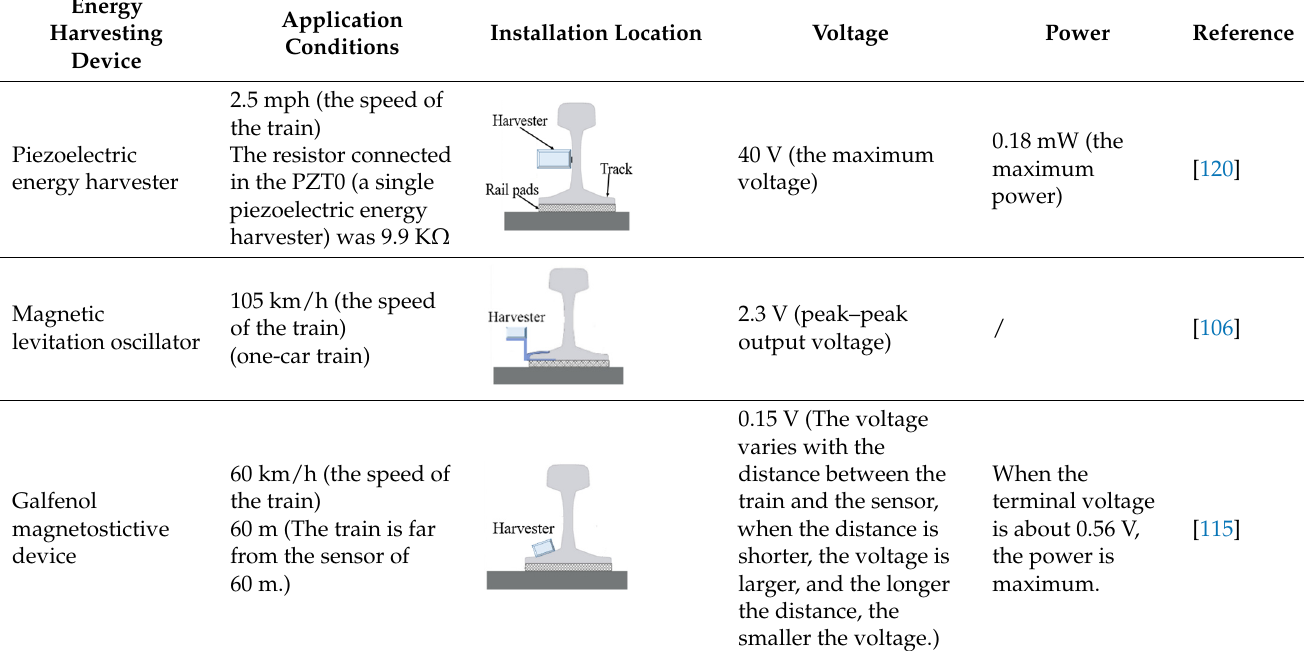
Table 9. Comparison of energy harvesters based on vibration principle.